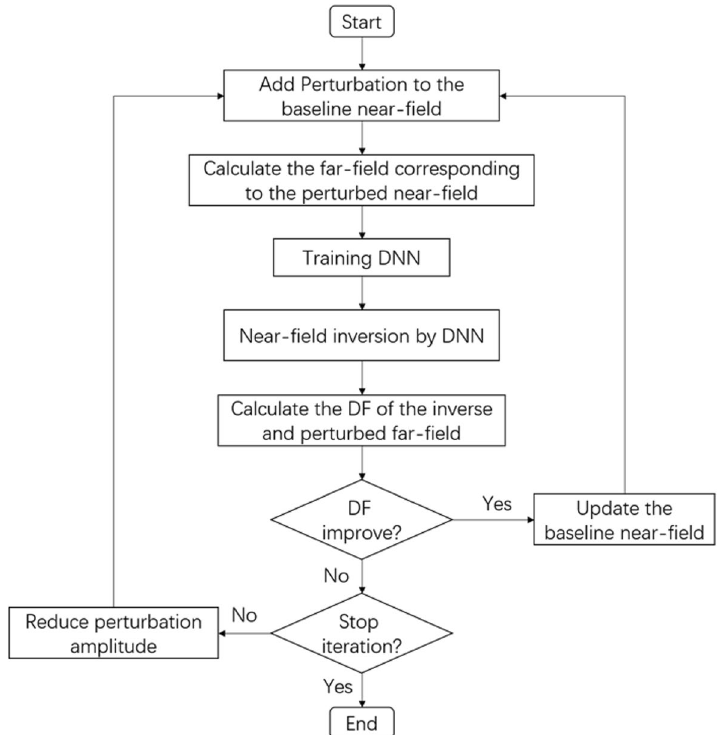
Fig. 4 The inverse design framework